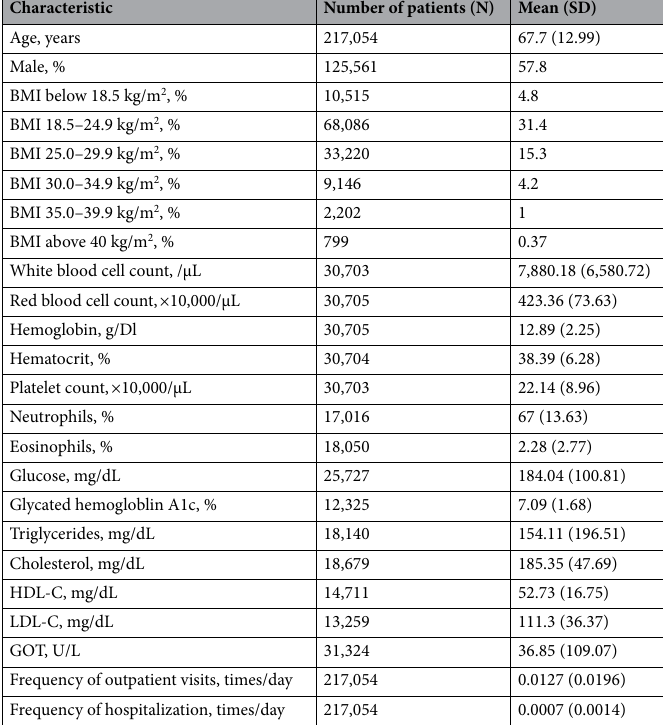
Table 1. Baseline characteristics. BMI body mass index, GOT glutamic oxaloacetic transaminase, HDL-C high-density lipoprotein cholesterol, LDL-C low-density lipoprotein cholesterol, SD standard